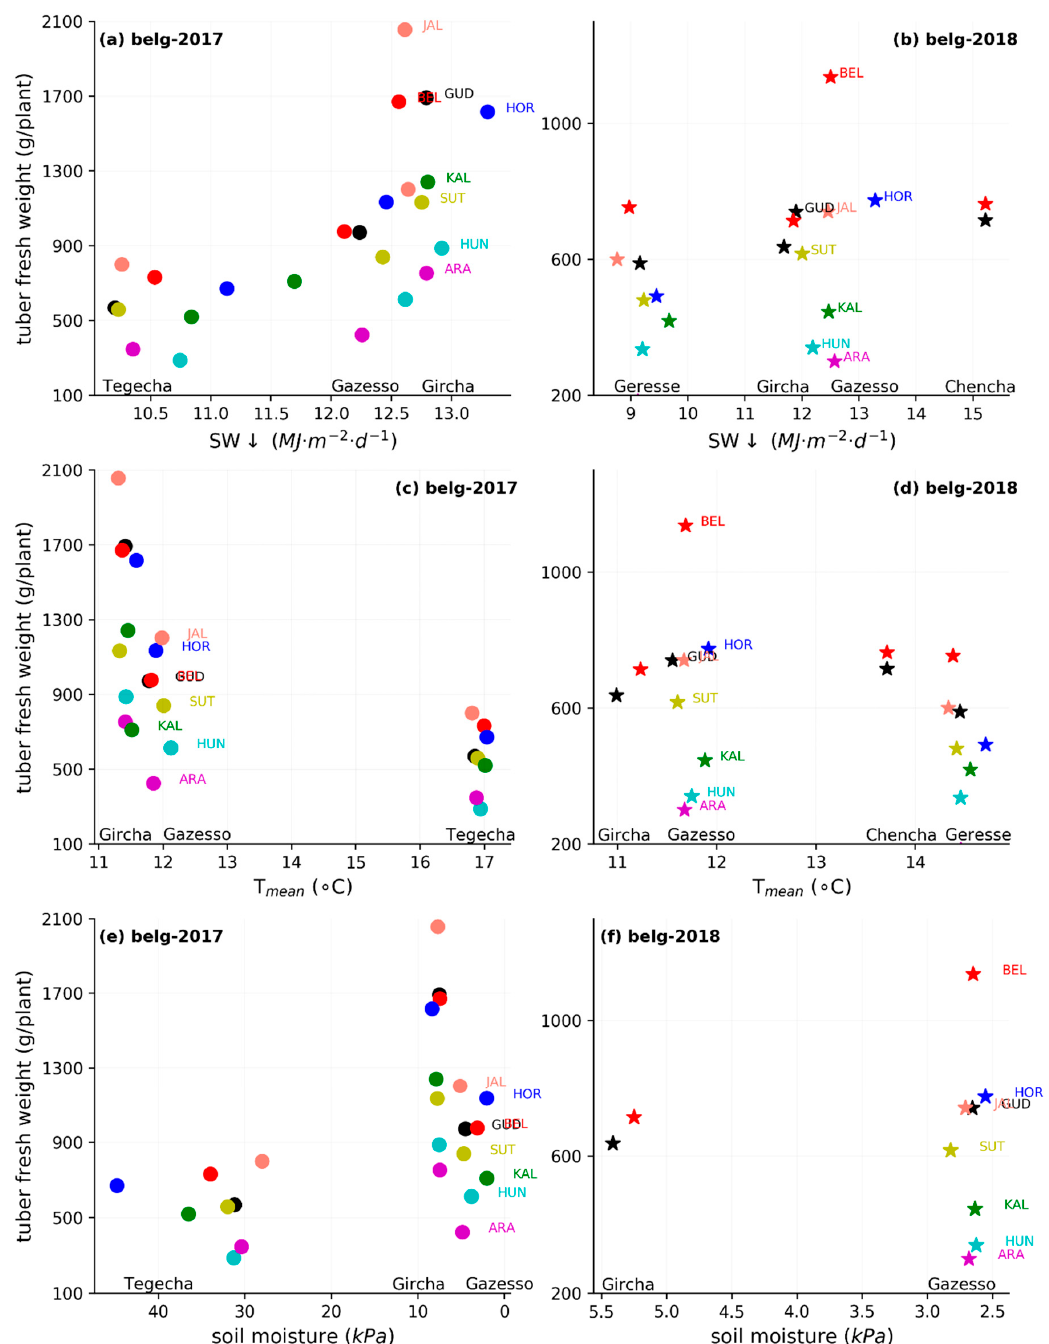
Figure 10. Tuber fresh weight gram per plant (g/plant) at harvest as a function of mean SW ↓ (MJ · m − 2 · d − 1 ) (upper row—a, b), Tmean ( ◦ C) (middle row—c, d), and soil moisture tension ( ψ ) (kPa) (lower row—e, f). The left panels show belg -2017 and the right panels indicate belg -2018. The cultivars were Ararasa —ARA, Hunde —HUN, Suthalo —SUT, Kalsa —KAL, Horro —HOR, Belete —BEL, Gudene —GUD, and Jalene —JAL as marked in colors. The weather station/farm names are indicated below the corresponding dataset shown in the scattered dots. The SW ↓ , T mean and ψ are average values in the period from P2 to P3. Note that from farms in belg -2017 and belg -2018, those farms with available SW ↓ , T mean , and ψ data records are included here. Note that the mean value of ψ at four soil depths (5, 10, 20, and 40 cm) are reported; and ψ = 200 kPa is a fully dry soil and ψ = 0 kPa means a fully saturated soil.